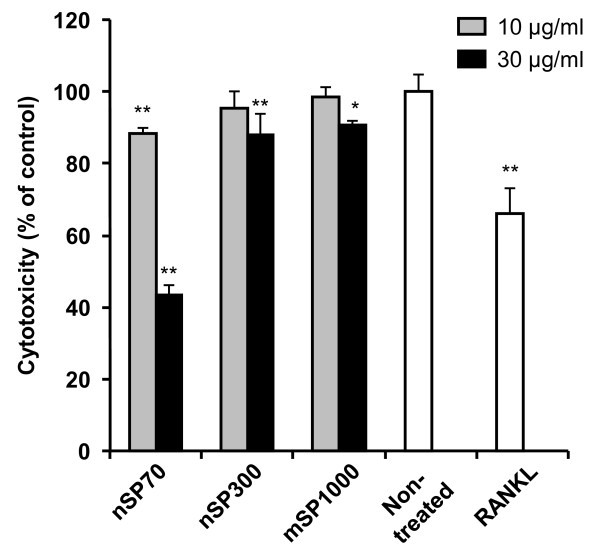
Effect of silica particles on cytotoxicity. The cytotoxicity of RAW264.7 cells after incubation with nSP70, nSP300 or mSP1000 for 5 days was evaluated using the WST-8 assay. The percentage increase in cytotoxicity was calculated relative to the negative control. Data are expressed as the mean ± SD (n = 3). *P < 0.05, **P < 0.01 vs non-treated.